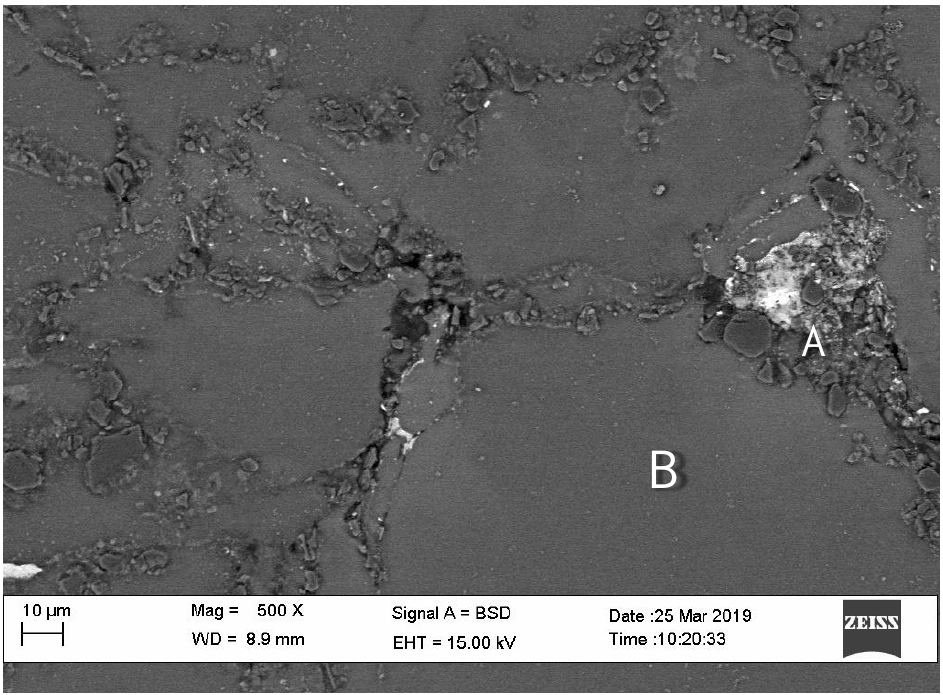
Figure 4. SEM micrograph for overall microstructure of 10 wt.% Al 2 O 3. Points A and B are for EDX point analysis.